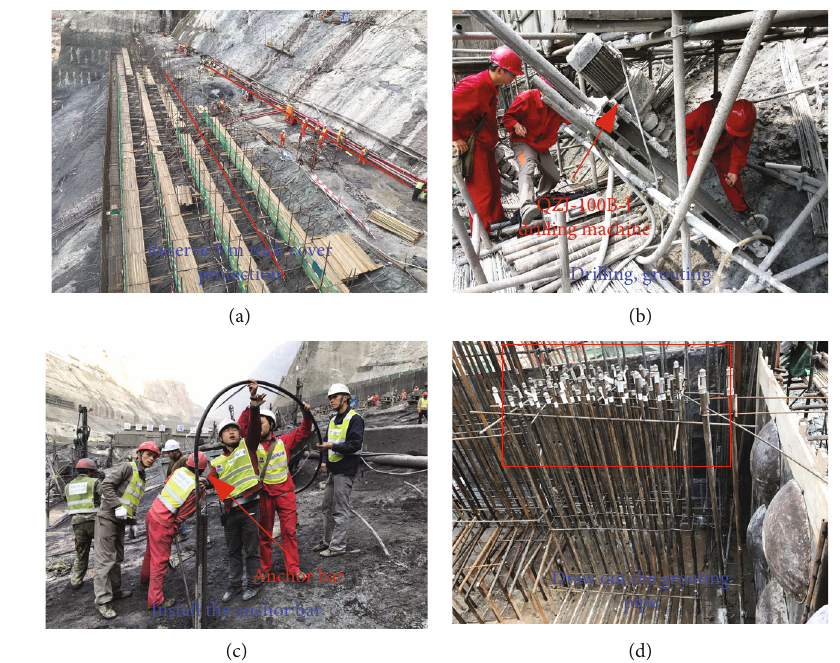
Figure 7: Construction technology of overburden weight